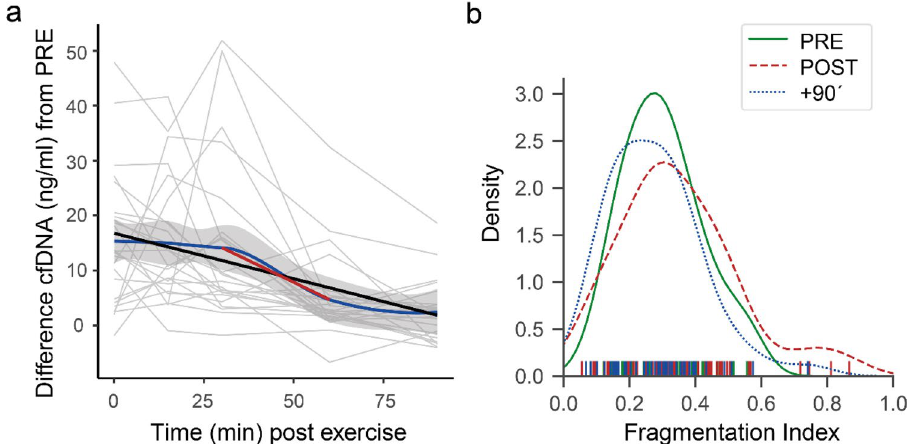
Figure 5. cfDNA decay and fragmentation index. ( a ) The ‘loess’ regression line (blue, with 95% CI in grey) indicates that levels of cfDNA remain increased until 30 min post exercise and decrease most strongly between + 30´ and + 60´ (red linear regression line). ( b ) Distribution of the fragmentation index of all study samples. The figure ( a ) was produced using the R (v3.6.3) 31 package ggplot2 (v3.3.2) 36 , figure ( b ) using the Python (v3.7.6) 28 libraries matplotlib (v3.1.1) 29 , and seaborn (v0.9.0) 30